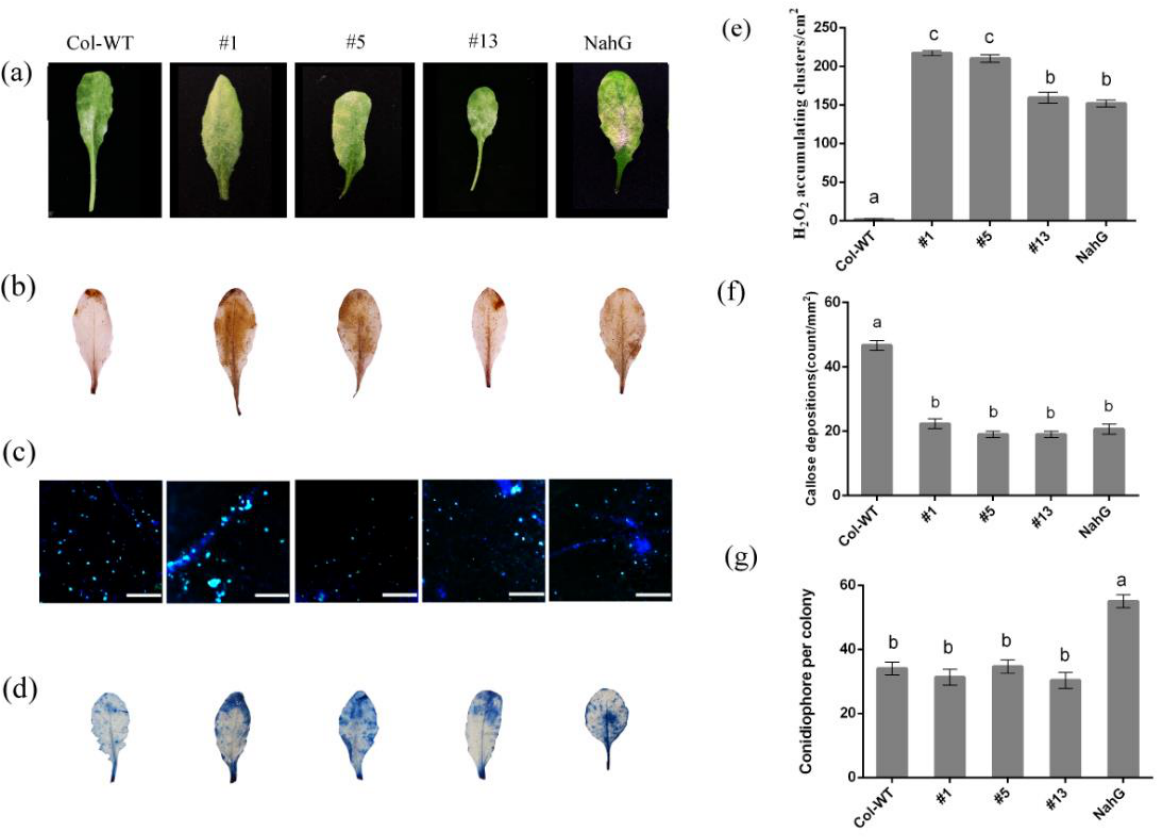
Figure 8. Phenotype of HbRPW8-a over-expressing lines in NahG background inoculated with E. cichoracearum . ( a ) Over-expressing lines (#1, #5, #13), NahG , Col-WT plants were infected with powdery mildew and photographed at 7 dpi; Col-WT as a control, its disease syptom was the same as that of transgenic lines. The NahG disease syptom was serious, with a large number of hyphae covered on leaves. ( b ) the accumulation of ROS and cell death in over-expressing lines, NahG and Col-WT leaves, photographed at 3 dpi; in NahG background, plant leaves with a large number of ROS clusters, but a few in Col-WT leaves ( c ) plant cell callose deposition were stained with DAB at 48 hpi in over-expressing lines, NahG and Col-WT leaves, and observed under microscope UV light; in Col-WT leaves, there were a large number of callose deposition, but a few in NahG background plant leaves, s cale bar = 100 μm. ( d ) Severe cell death occured in NahG background plant leaves, photographed at 3 dpi; ( e ) representation of DAB-positive stained clusters in over-expressing lines, NahG and Col-WT leaves. Number of stained clusters was calculated per cm 2 ; ( f ) average numbers of callose deposits per 1 mm 2 are displayed in over-expressing lines, NahG and Col-WT leaves at 48 hpi. ( g ) quantitative analysis of conidiophore formation on over-expressing lines, NahG and Col-WT leaves at 7 dpi. All the data were shown as the means ± SD from three independent experiments and columns with different letters indicate significant difference ( p < 0.05).